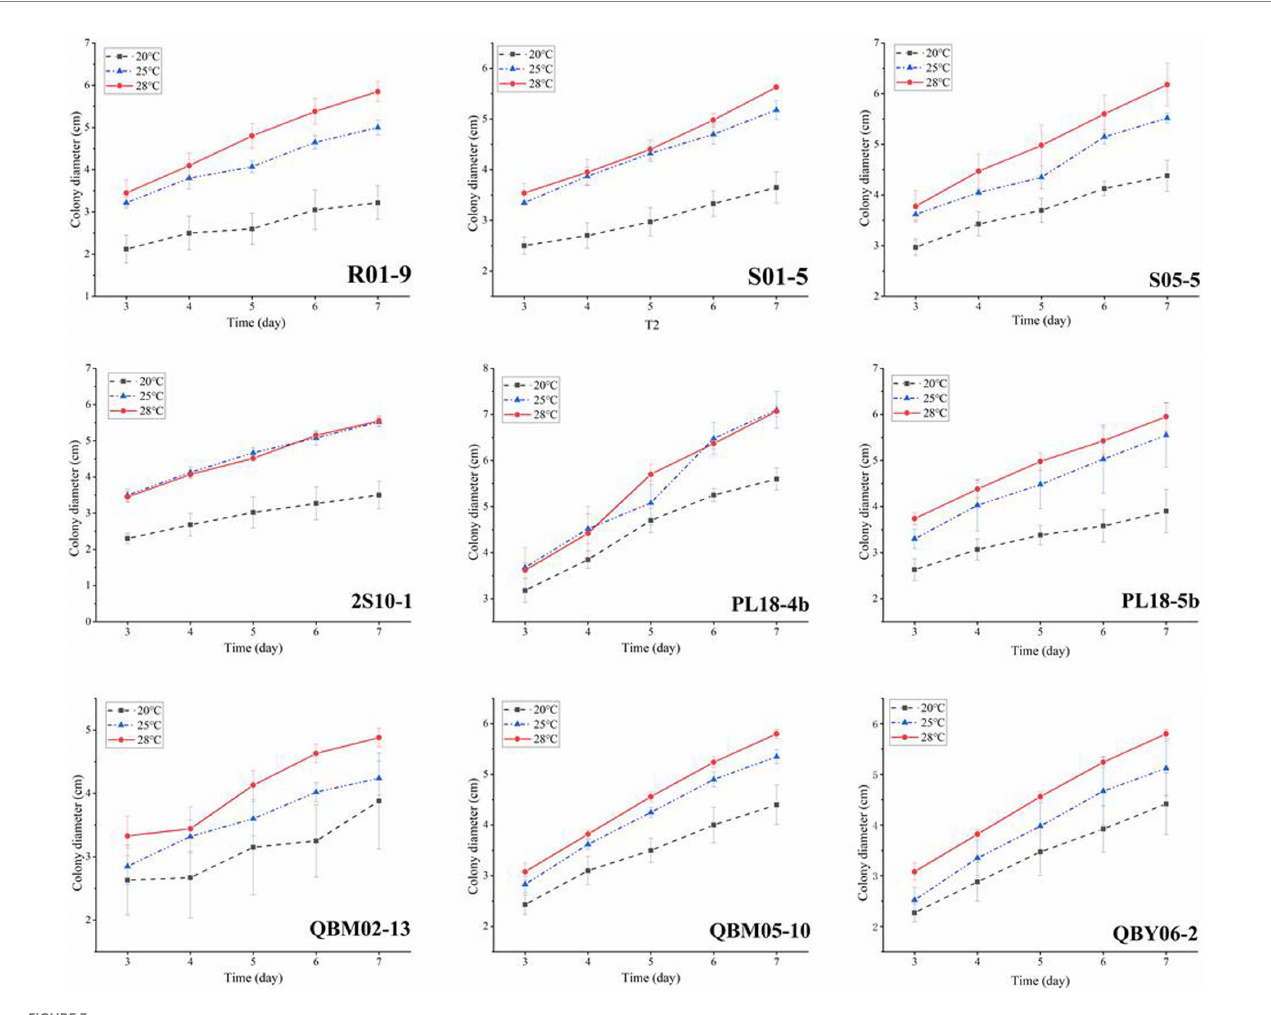
FIGURE 3 The effect of temperature on the growth of nine Alternaria